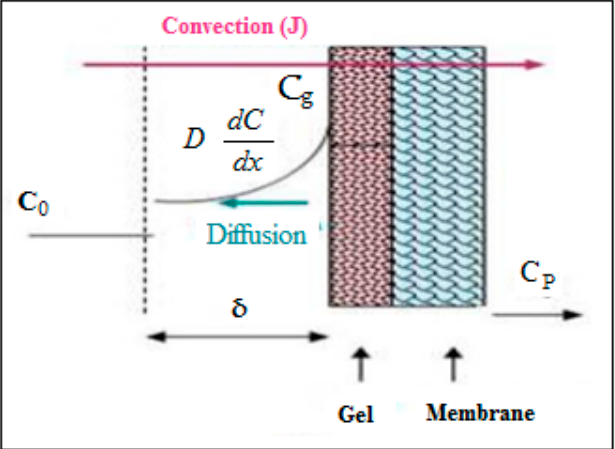
Figure 2. Schematic representation of concentration polarization